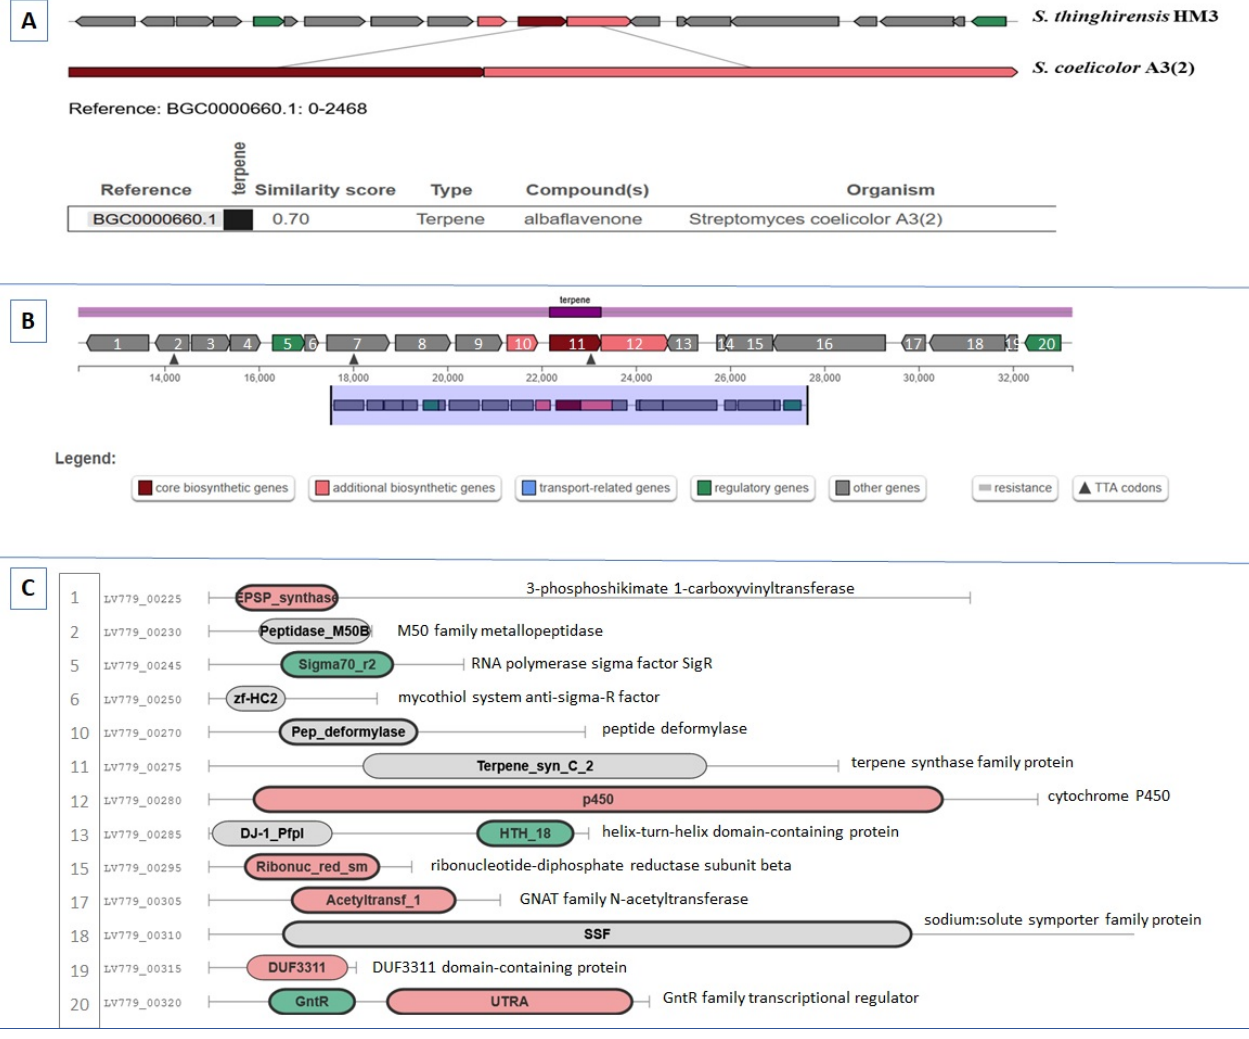
Figure 3. Terpene (albaflavenone) biosynthetic gene cluster in S. thinghirensis HM3. ( A ) The com- parison between the proposed albaflavenone gene cluster (dark red gene) in strain HM3 and the proposed identified cluster of albaflavenone in S. coelicolor A3(2) with a similarity score of 0.7 on the MIBiG website. ( B ) The proposed albaflavenone gene cluster in region 2.1 from strain HM3 genome; 3, SOS response-associated peptidase; 4, hydrolase; 7, HD-GYP domain-containing protein; 8, metal- dependent phosphohydrolase; 9, 14 hypothetical protein; 16, ribonucleoside-diphosphate reductase subunit alpha. ( C ) represents the predicted genes involved in albaflavenone biosynthesis based on the Pfam website.